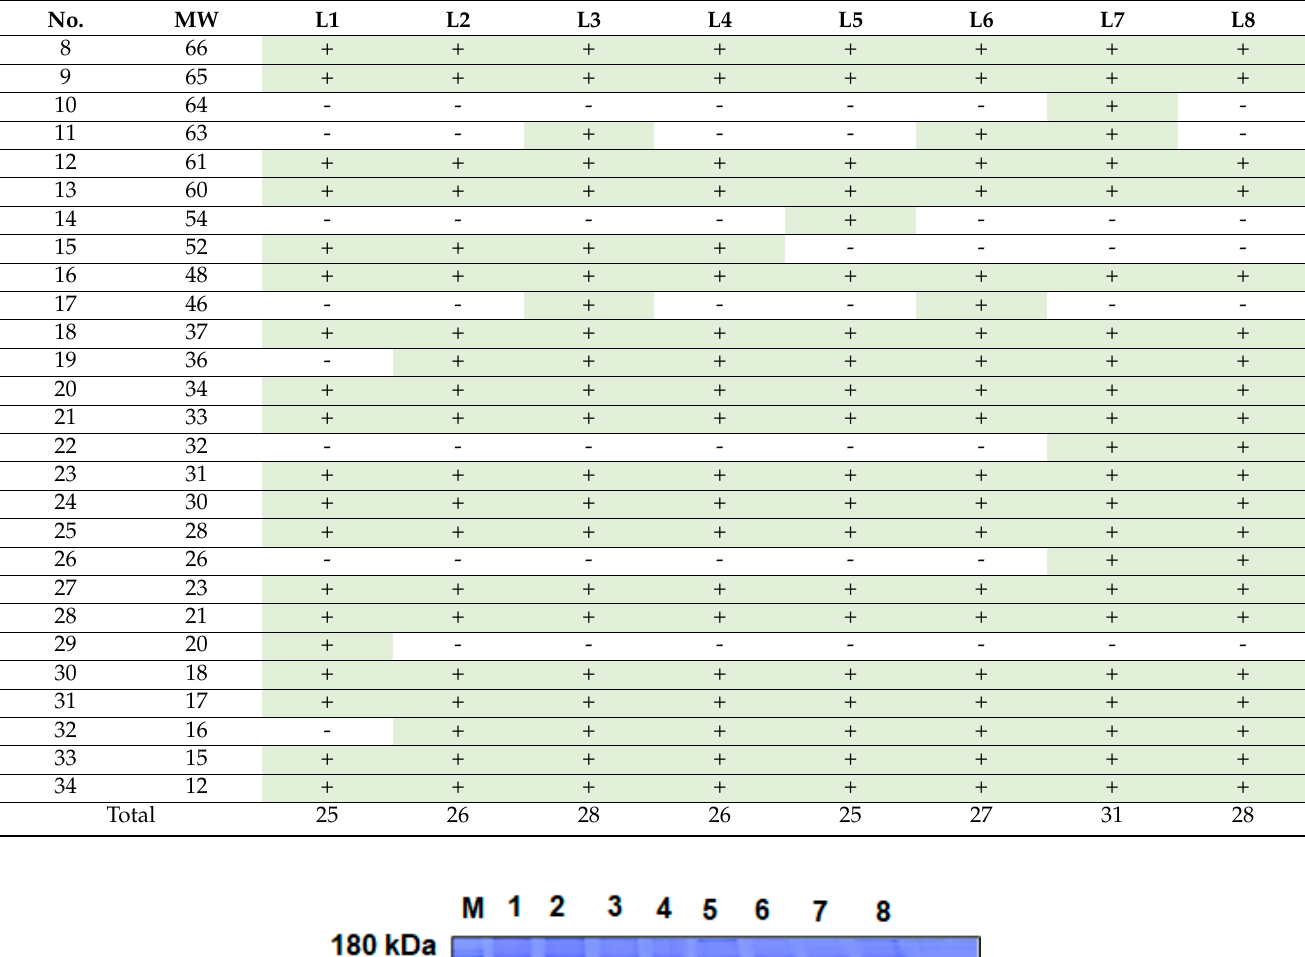
Figure 3. Change in total phenols ( A ) and total flavonoid ( B ) levels in wheat plants pretreated with putrescine, drought stressor, and their combination. Each bar shows mean ± standard error. Differ- ent letters indicate different significance between means.